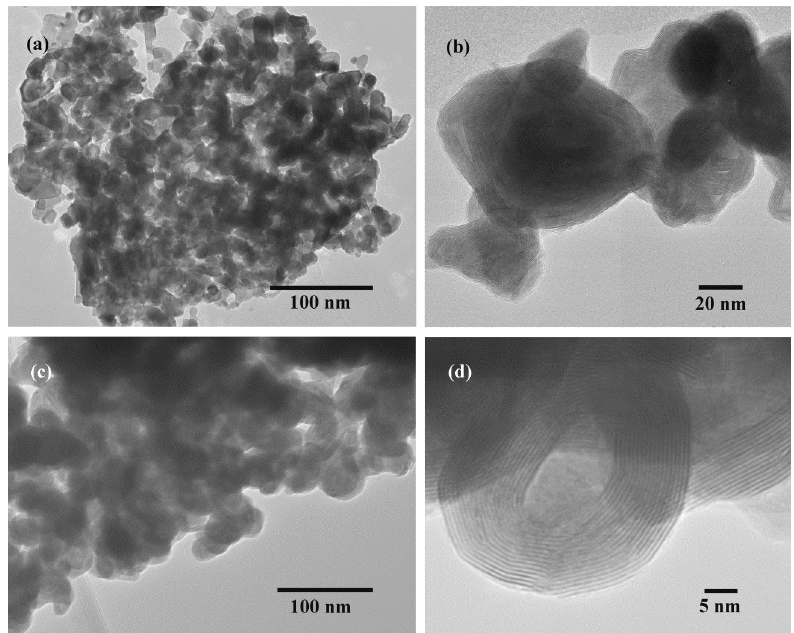
Figure 15. TEM images for particles collected from the hot zone from experiment FB2, showing overall uniformity of particles ( a and c ) and detailed closed-cage feature under high resolution ( b and d